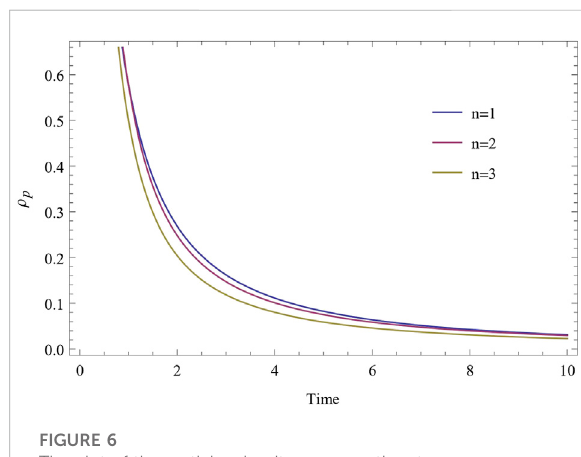
FIGURE 6 The plot of the particles density ρ p versus time